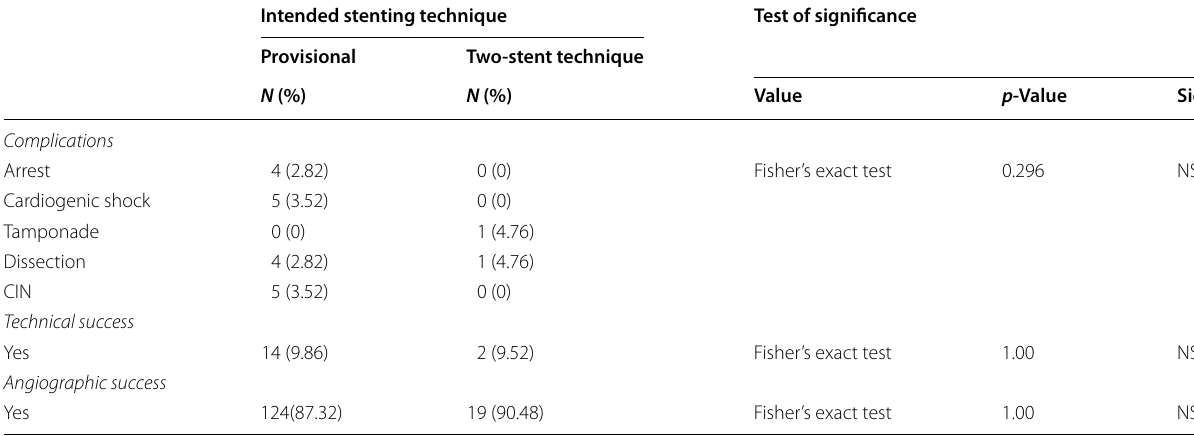
Table 5 Procedural outcomes Intended stenting